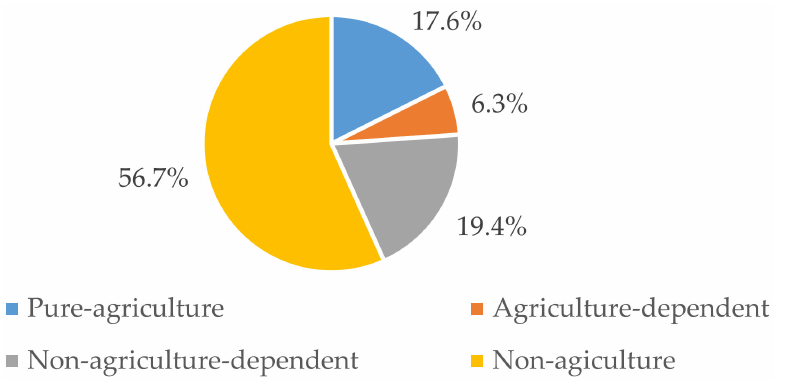
Figure 3. Ratio of household livelihood strategies in the study